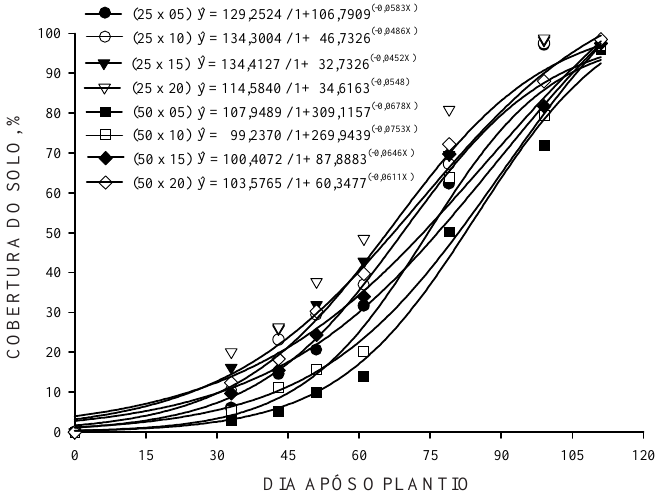
Figura 2. Taxas de cobertura do solo (Y) por cudzu tropical, considerando diferentes espaçamentos e densidades de plantio. Equações significativas a 1% pelo teste F, com R 2 =